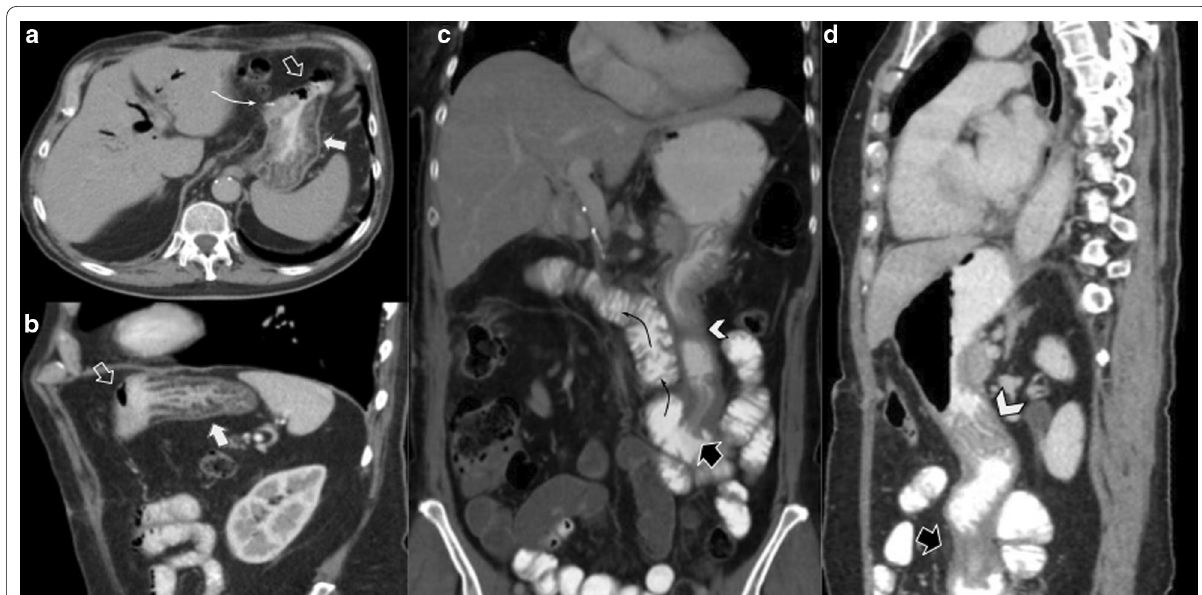
Fig. 5 Gastrojejunostomy and duodenojejunostomy: ( a , b ) Gastrojejunostomy. Axial and sagittal portal venous phase CT scan, respectively. ( c , d ) Duodenojejunostomy. Coronal and oblique sagittal view portal venous phase CT scan, respectively. Note the importance of using positive oral contrast to denote marked mucosal pattern change in A and B, and to depict the pylorus and latero-terminal anastomosis in duodenojejunostomy. References: White curved arrow: Surgical clips; Thick white arrows: gastric remnant; black arrows: ascended jejunal loop; Thick black arrow: latero-terminal anastomosis; arrowhead: pylorus; curved black arrows: oral contrast reflux to afferent limb. Black arrows: ascended jejunal loop